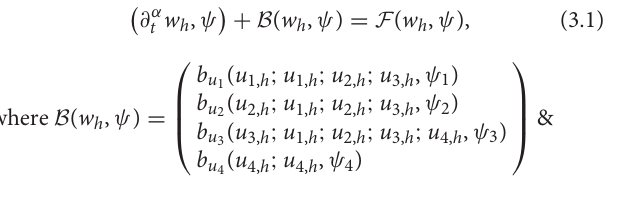
TABLE 1 | Errors and order of convergence when α = 0.4. TABLE 2 | Errors and order of convergence when α =